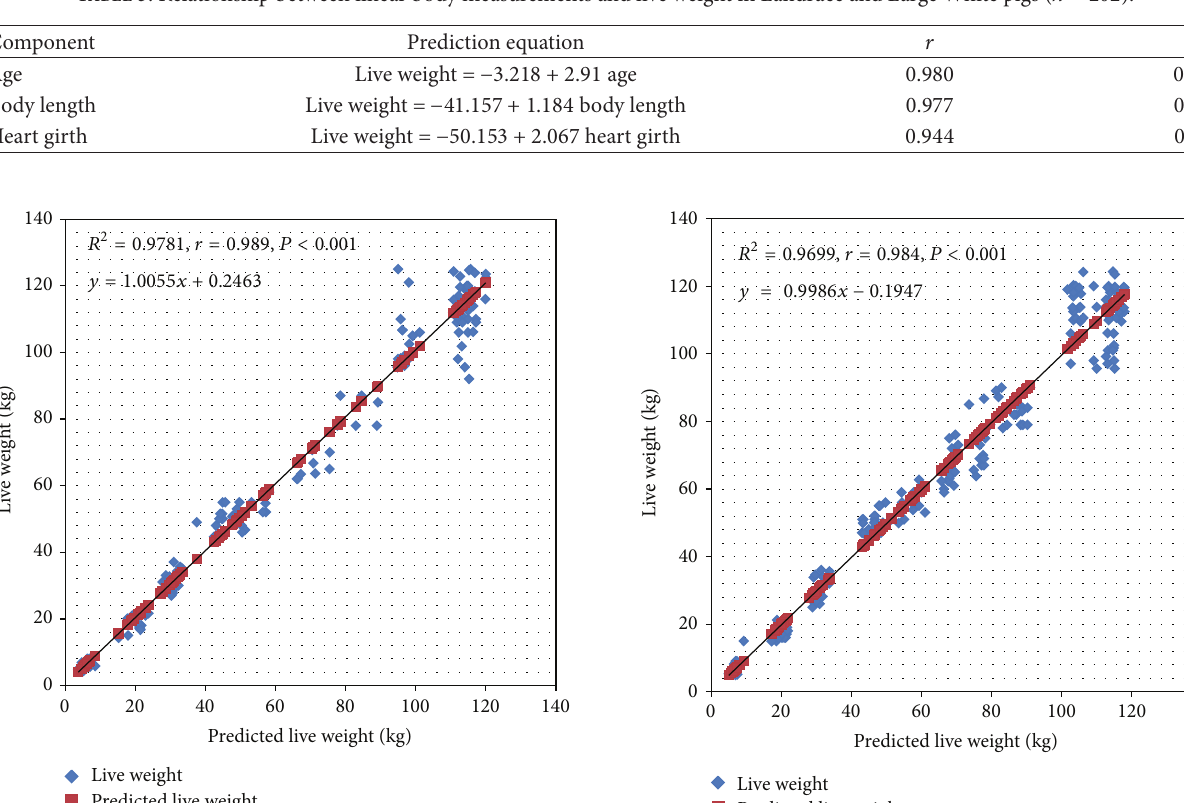
Table 3: Relationship between linear body measurements and live weight in Landrace and Large White pigs ( 𝑛 = 202 ).